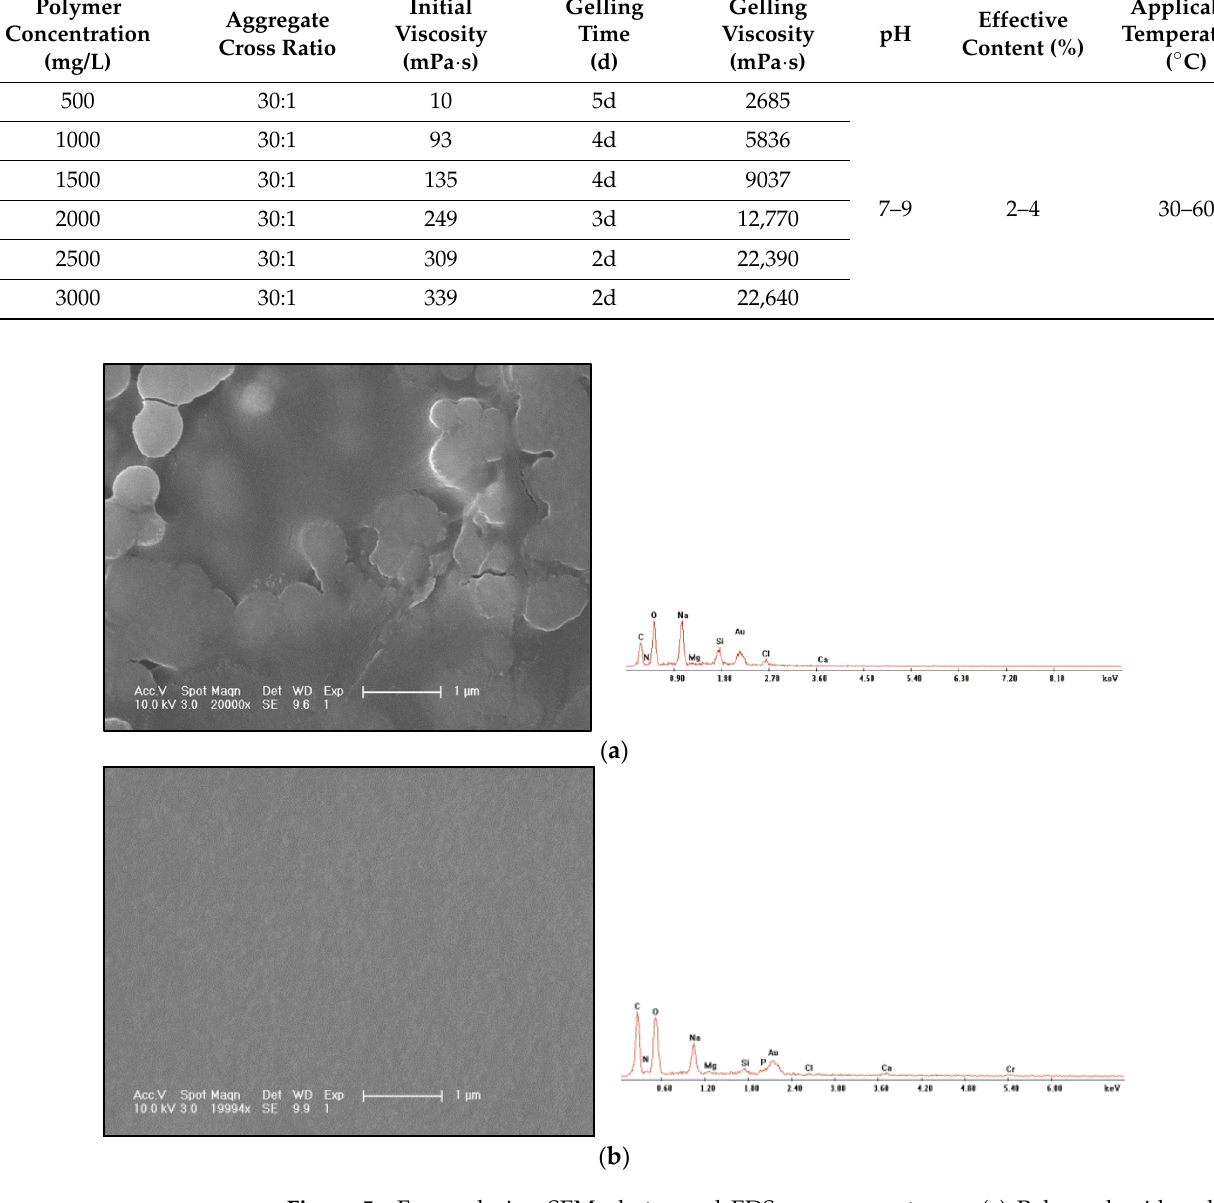
Table 7. Crosslinking agent performance evaluation test result table.